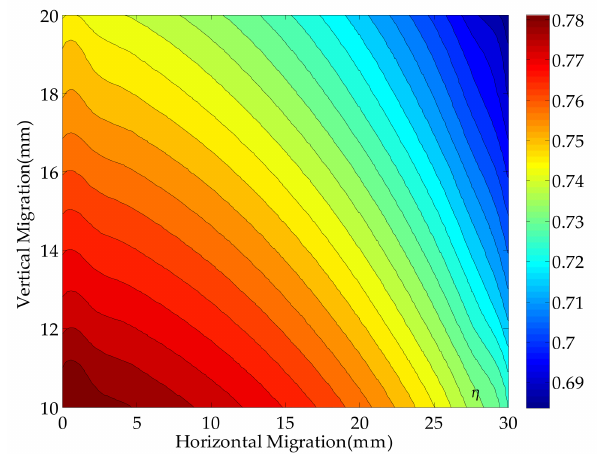
Figure 11. Output efficiency with misalignment.